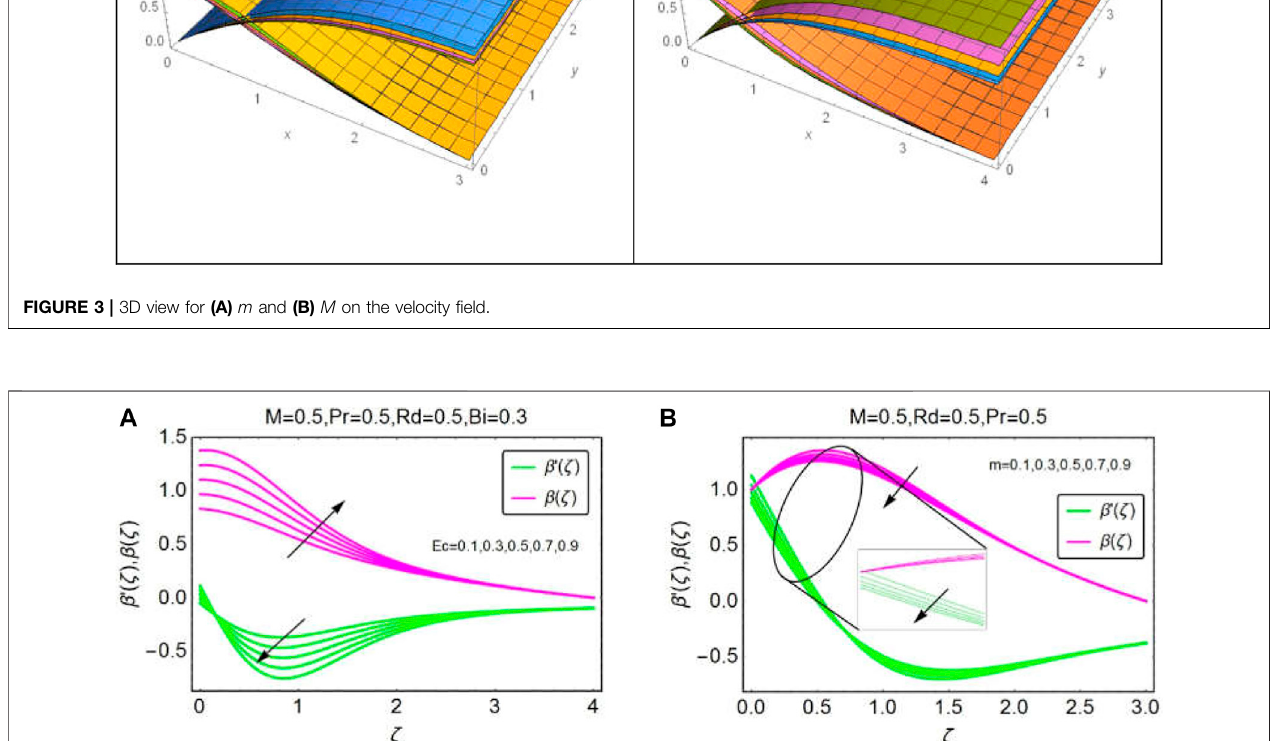
Frontiers in Physics |